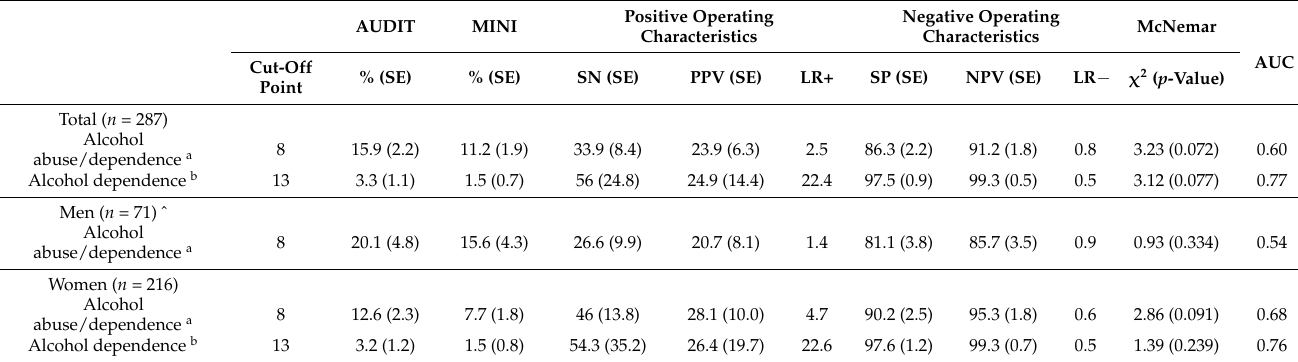
Table 5. Operating characteristics of AUDIT online questionnaire cut-off points for estimating reference standard (MINI) prevalence of alcohol dependence and alcohol abuse or dependence by gender (weighted